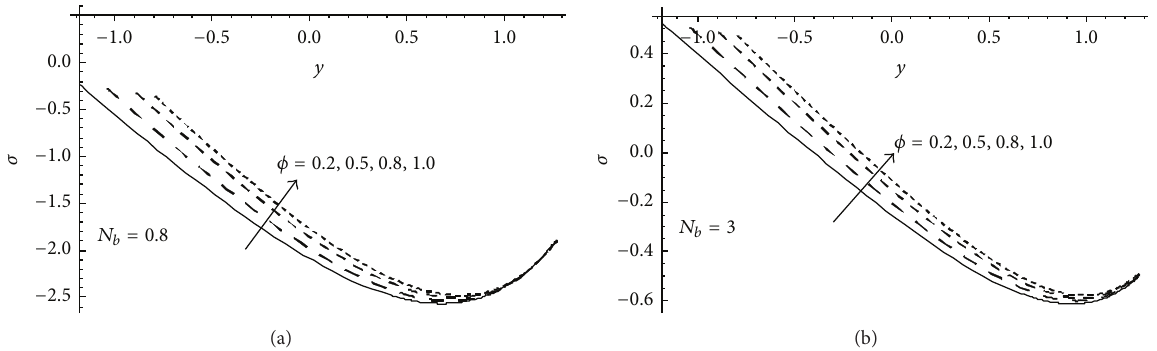
Figure 8: Variation of nanoparticle concentration at different values of 𝜙 when 𝑁 𝑡 = 5 , 𝑑 = 1 , 𝑎 = 0.5 , 𝑥 = 1 , 𝑏 = 0.5 , 𝛾 = 0.7 , and 𝛾 1 = 0.7 for (a) 𝑁 𝑏 = 0.8 and (b) 𝑁 𝑏 = 3 .